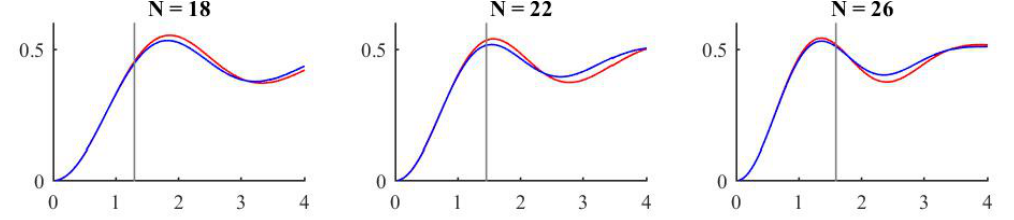
Figure 24 . We compare the expectation value of hf 1 ( t ) ; 2 (0) g 2 i in the thermal state (blue) and pure state (red). The scrambling time is designated by the vertical line.